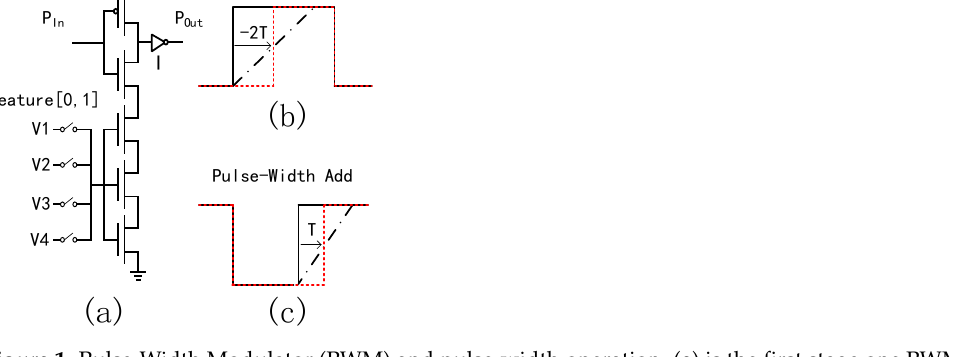
Figure 1. Pulse-Width Modulator (PWM) and pulse-width operation. ( a ) is the first stage one PWM core, it can control the pulse-width from P In to P Out according to feature [0, 1]; ( b ) is an example of subtraction of two units of pulse-width; ( c ) is an example of add of one units of pulse-width.